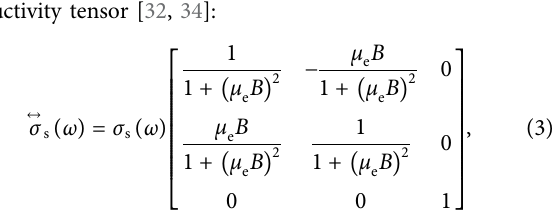
Frontiers in Physics |